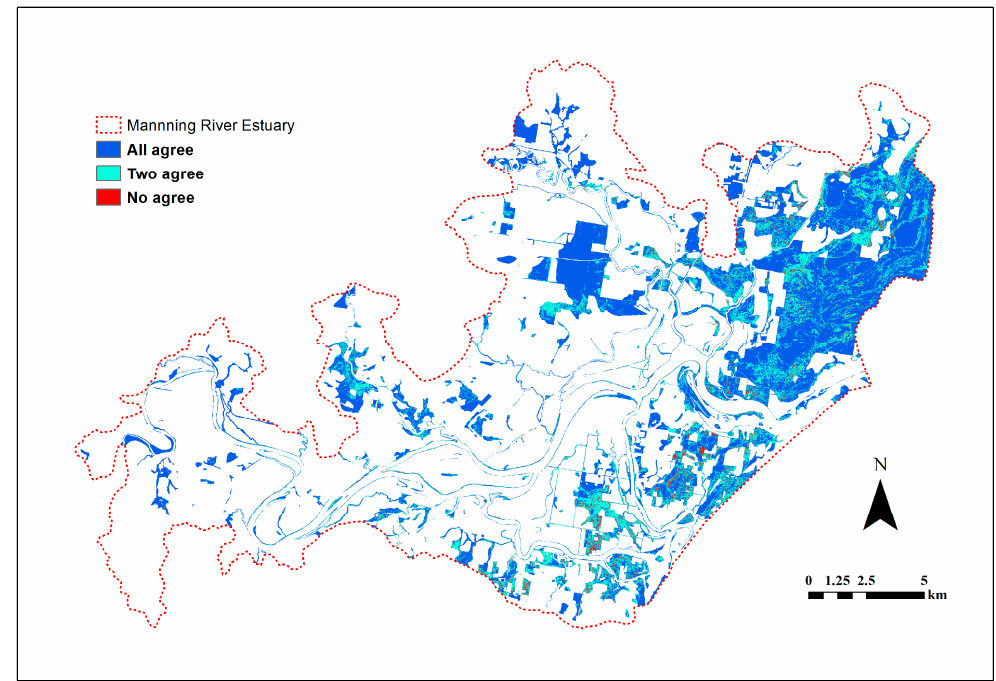
Figure 4. Map showing the locations where three classifiers (wsrf, xgbtree and svm) agree and disagree in predicting wetland types. The three classifiers predicted the same types for the majority of grids.